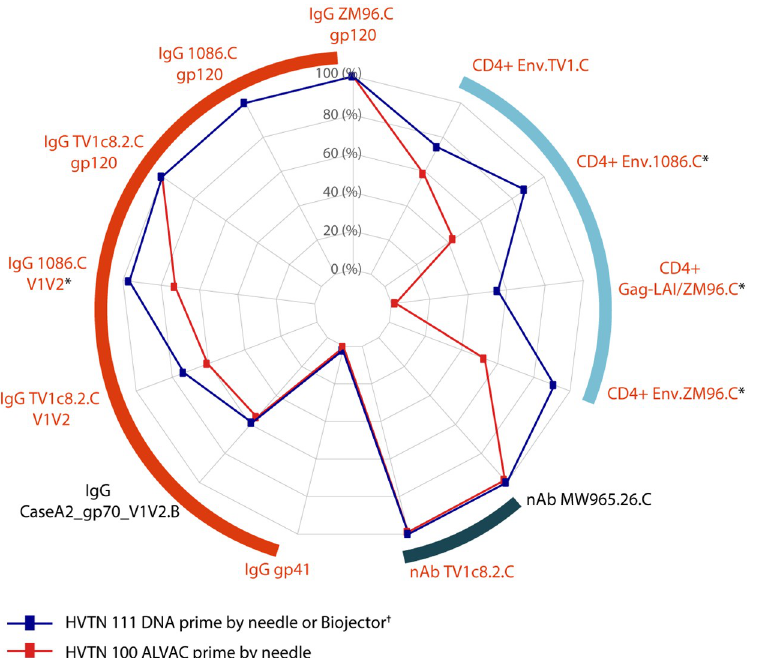
Fig 1. Radar plot of covariate-adjusted antibody and cellular response rates in HVTN 111 (DNA plasmid prime regimen) and HVTN 100 (ALVAC prime regimen) at month 6.5, two weeks after fourth vaccination. † HVTN 111 DNA plasmid prime by Biojector only for CD4+ response rates. � Barnard’s test and TMLE p < 0.05. Orange arc indicates bAb response rates, navy arc indicates nAb response rates, and light blue arc indicates CD4+ T-cell response rates. Orange font indicates the vaccine-matched antigens. Env, envelope; HVTN, HIV Vaccine Trials Network; IgG, immunoglobulin G; nAb, neutralizing antibody; TMLE, targeted minimum loss estimation; V1V2, variable 1 and